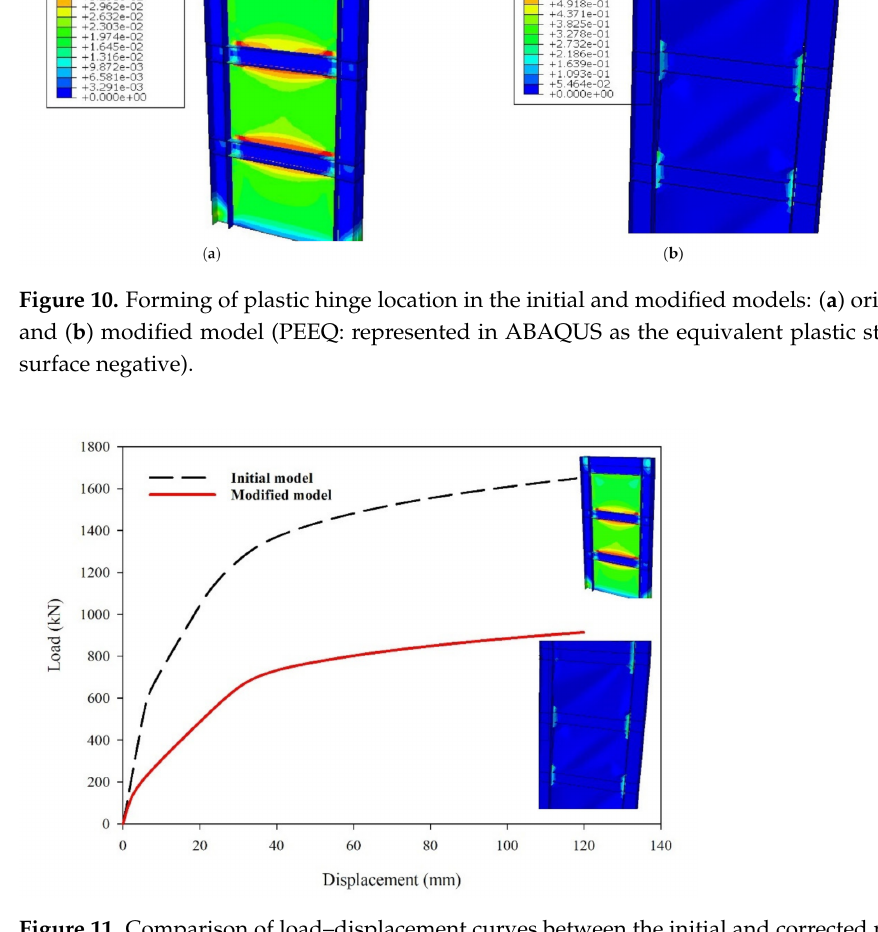
Figure 11. Comparison of load–displacement curves between the initial and corrected